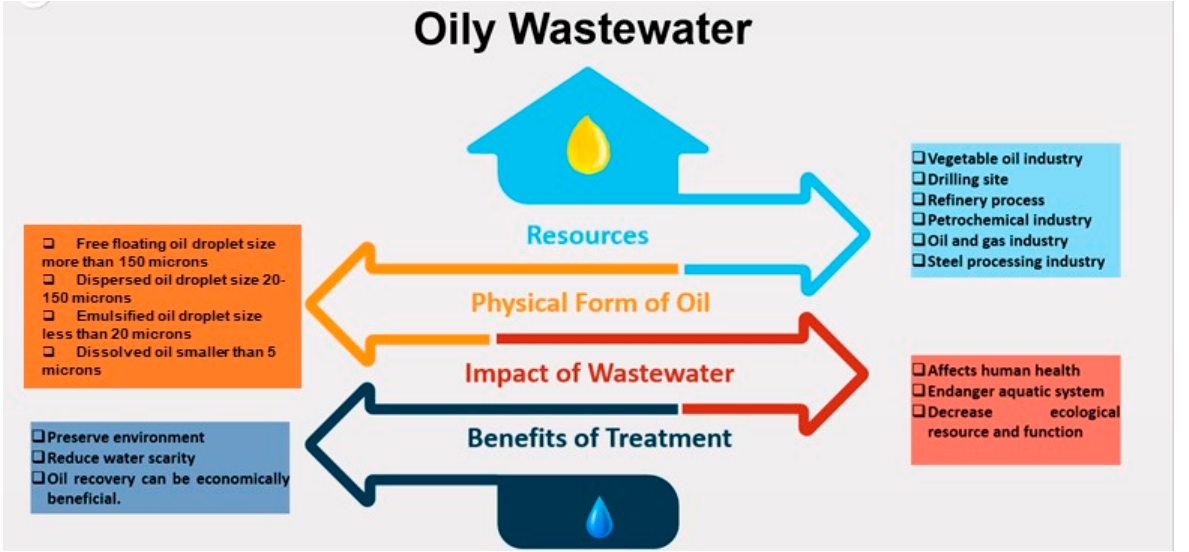
Figure 1. Oily wastewater resources, physical form, impact and benefit of treatment.